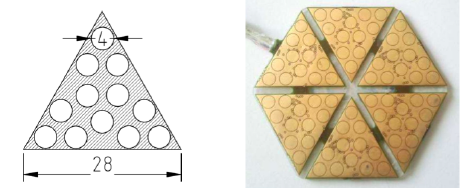
Figure 8. Six triangular modules (left) build up an hexagonal patch (right).